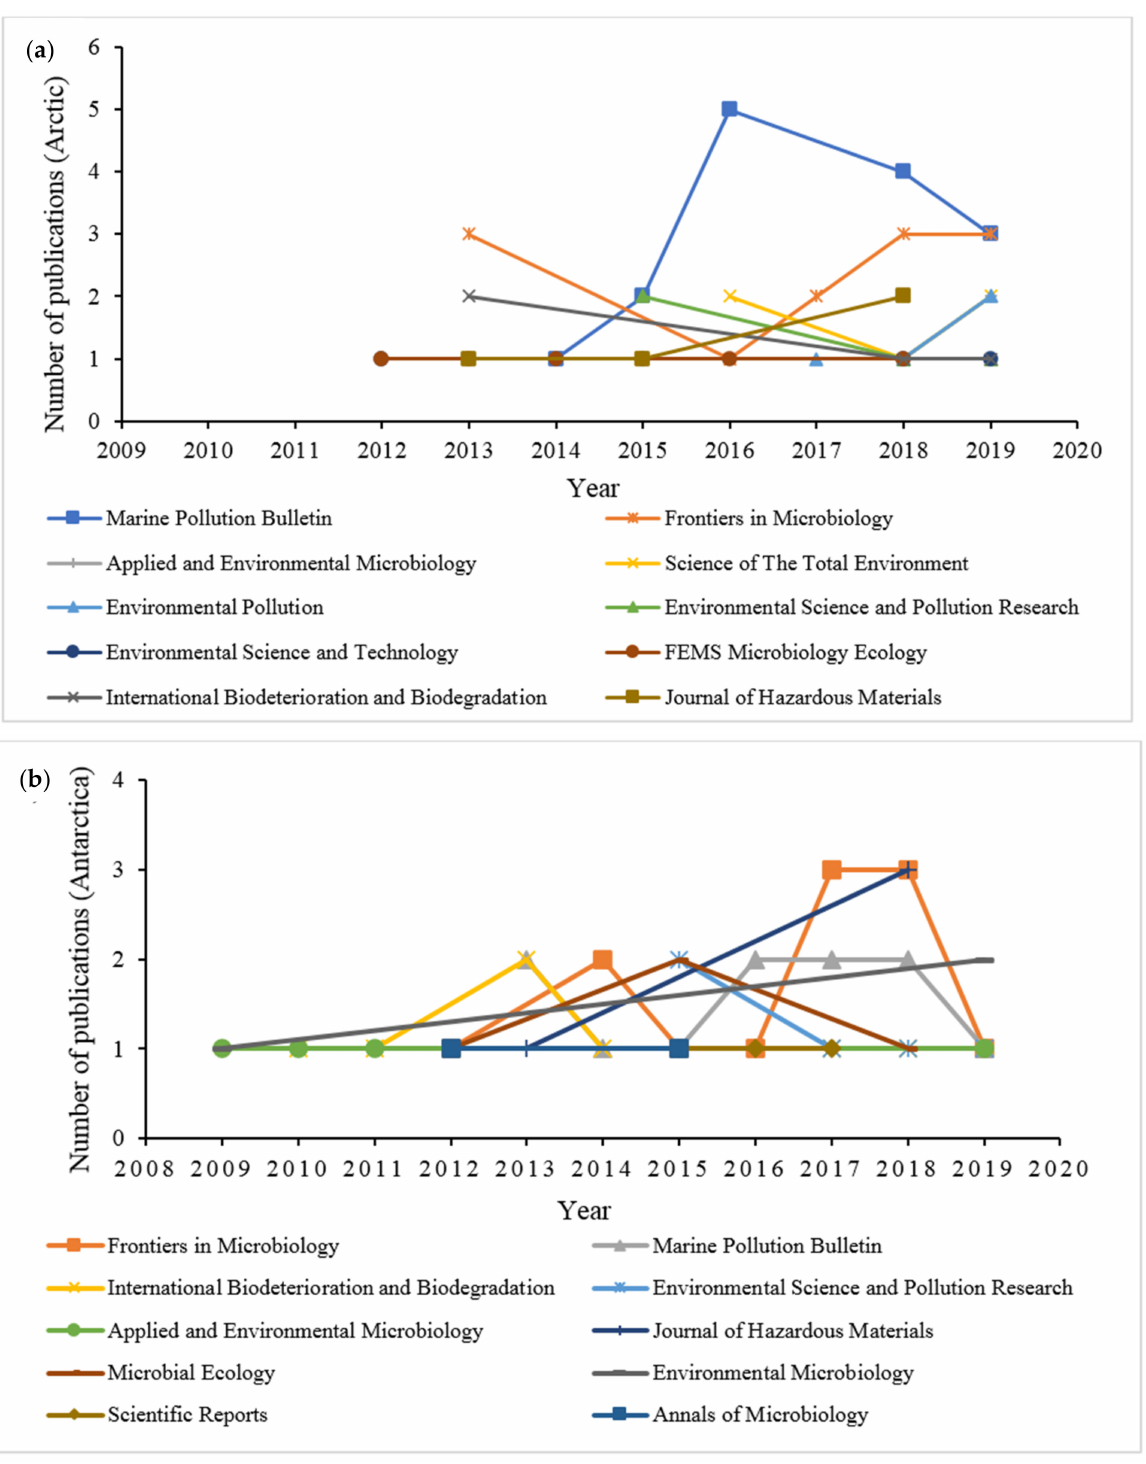
Figure 6. Trends of the top 10 source journals based on the degradation of hydrocarbon by microbial community in ( a ) Arctic and ( b ) Antarctic marine environments between 2009 to